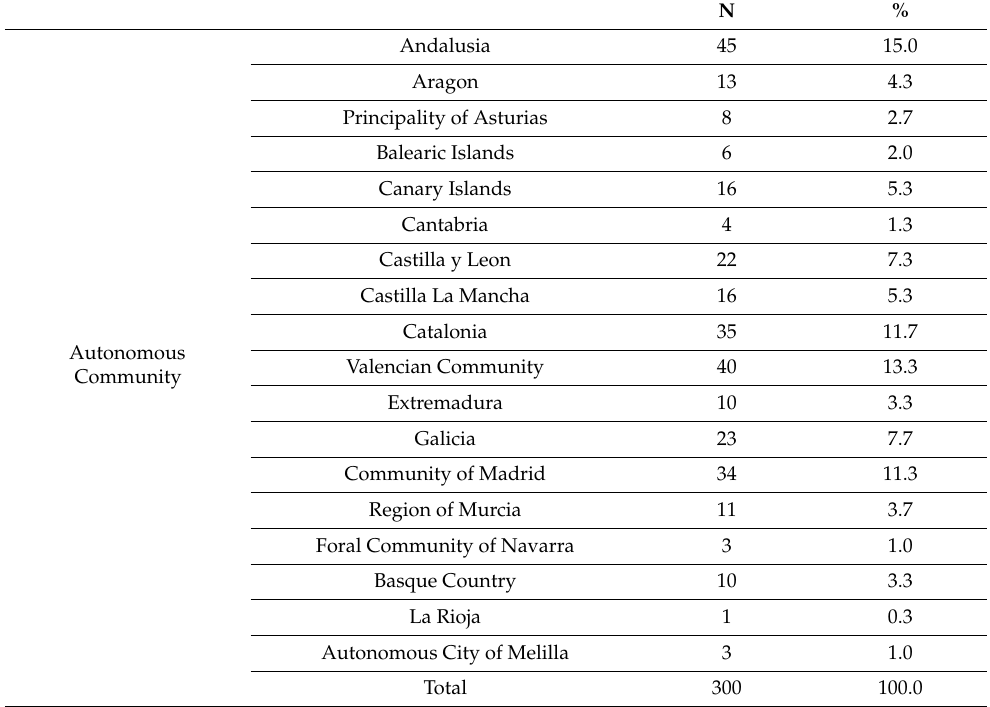
Table 1. Distribution of physicians who responded to the survey by Autonomous